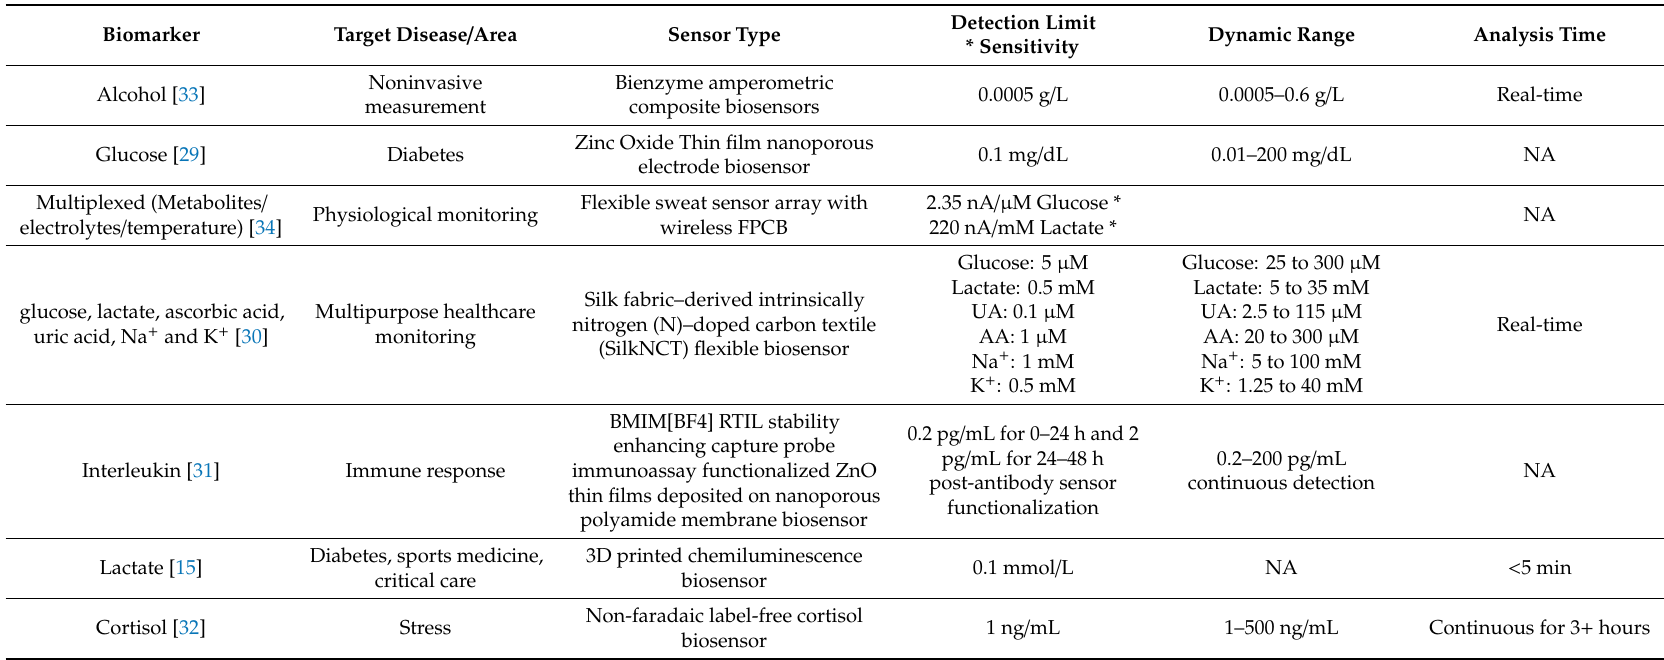
Table 2. Summary of Portable Biosensors for Sweat Biomarker